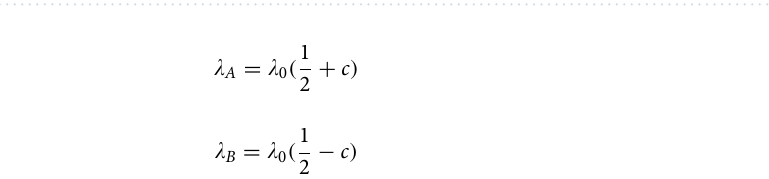
Figure 5. Model predictions based on N = 20,000 simulations with random values of Poisson inputs with parameter values λ A and λ B in the range 0–20. ( a ) Correct decisions as a function of the sum of inputs. ( b ) RT difference between erroneous and correct decisions based on a Monte Carlo analysis of the input space. Grey dots indicate the neighborhood when RTs on errors were longer than those on correct decisions. Red dots indicate the neighborhood when the opposite relationship held. The neighborhood (of maximum size ± 2.5) was set to contain at least 50 instances of erroneous decisions (a lower number of errors did not ensure enough stability). Otherwise, the point was not reported. The mean size of the neighborhood containing 50 errors was ±